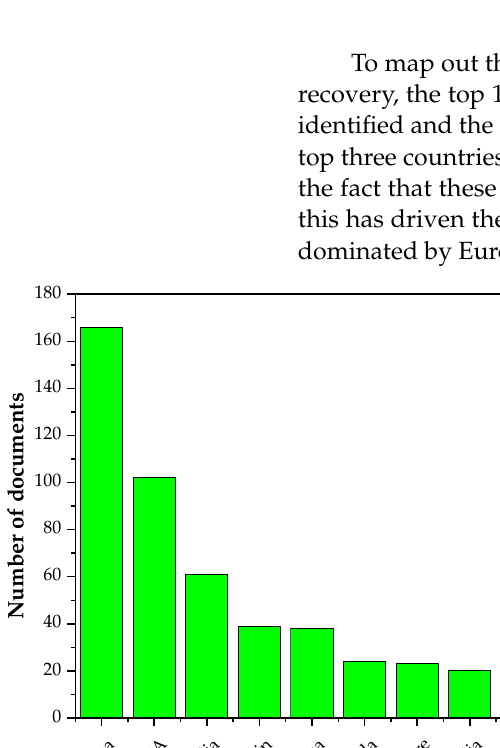
Figure 2. Top 10 countries in ( A ) publications number and ( B ) citations for research documents related to membrane application for nitrogen recovery from wastewater.